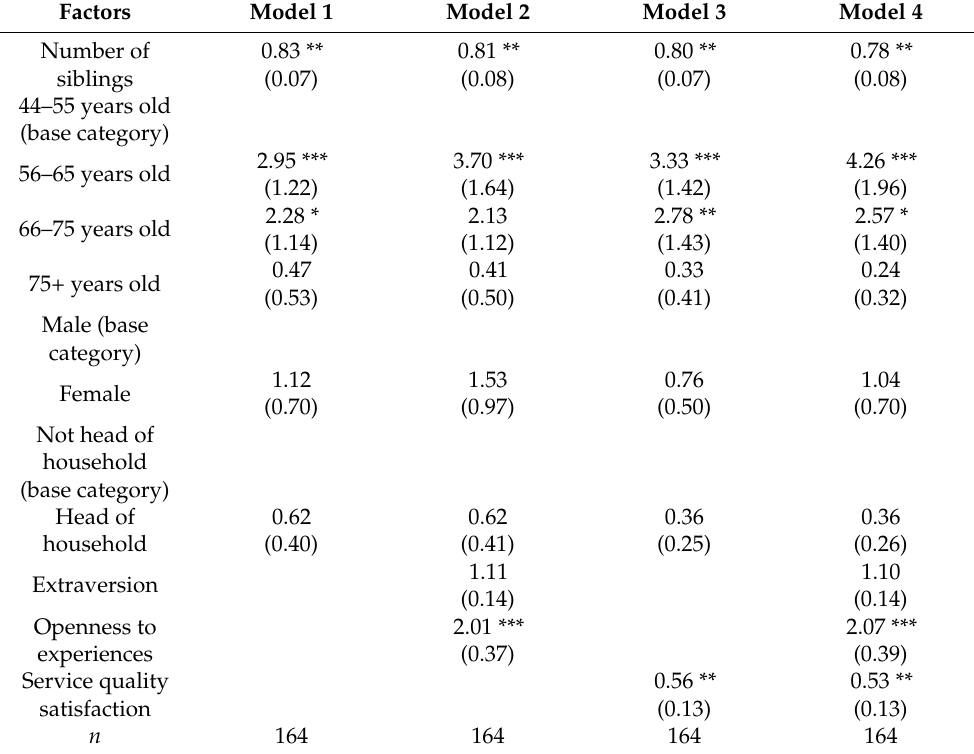
Table 2. Ordered Logistic Regression